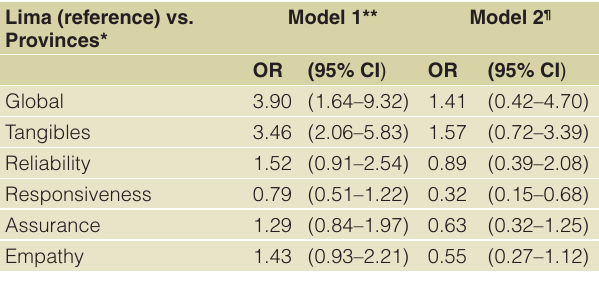
Table 4. Association of dissatisfaction, global and by domain, with city. Lima (reference) vs. Provinces*